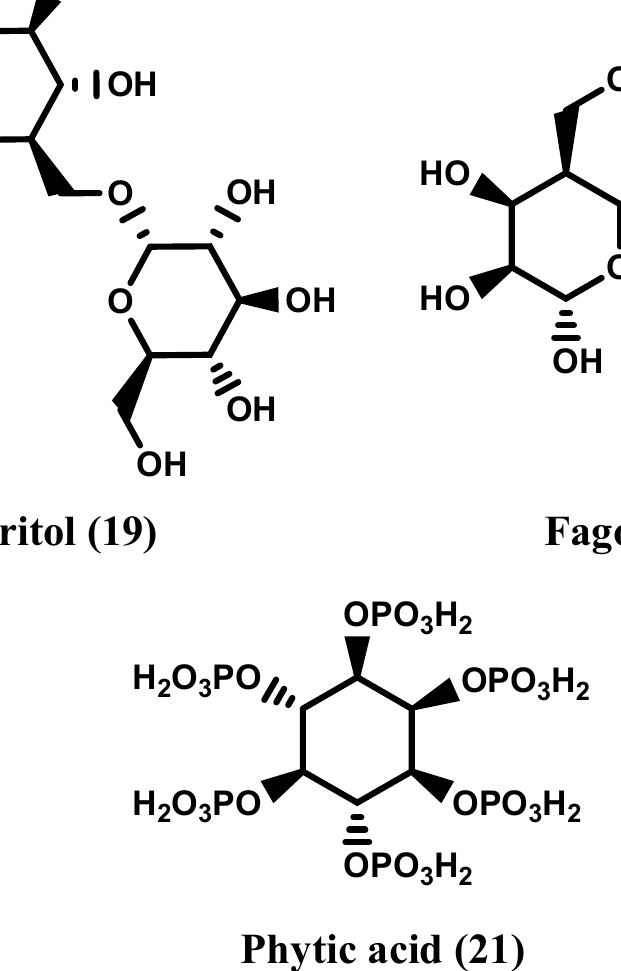
Figure 3. Glucosides derivatives of inositols and phytic acid. Another important class of biomolecules involving inositols is represented by sphin- golipids, one of the most significant lipid class present in the plant plasma membrane [29]. These compounds, as the inositols, are ubiquitous to eukaryotes and assume a strategic importance in living organisms being involved in growth, cellular signaling, stress re- sponses etc. In plants and fungi, the main sphingolipds are glucosyl inositol phosphoryl ceramides (GIPCs) [30–33], which are not present in mammalian organisms [34] (Figure